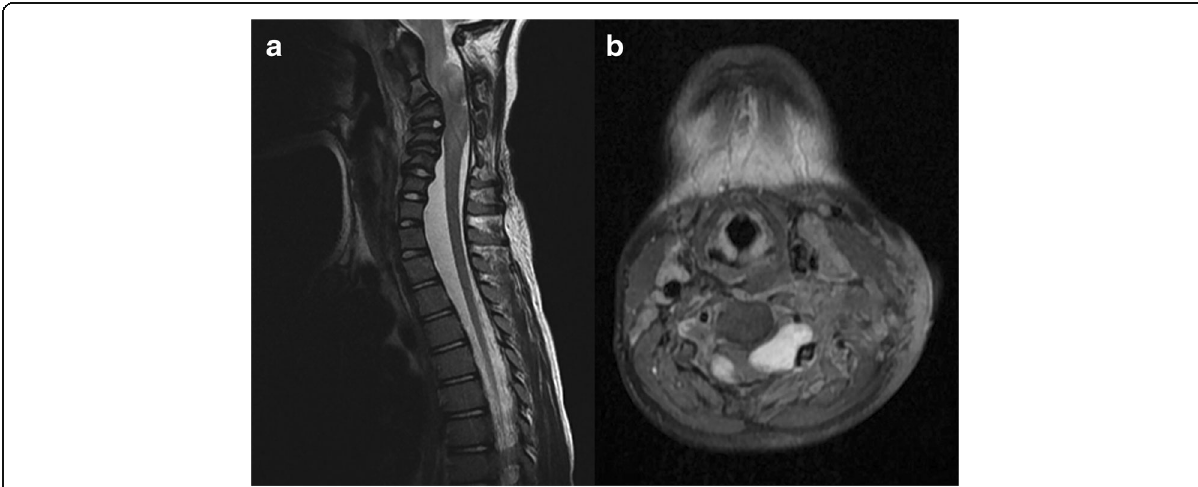
Fig. 1 a T2-weighted sagittal MRI showing significant compression of the spinal cord, dystrophic changes, and kyphotic deformity of cervical vertebrae and widening of spinal canal. b Bilateral dumbbell-shaped lesions on contrast-enhanced T1 weighted axial